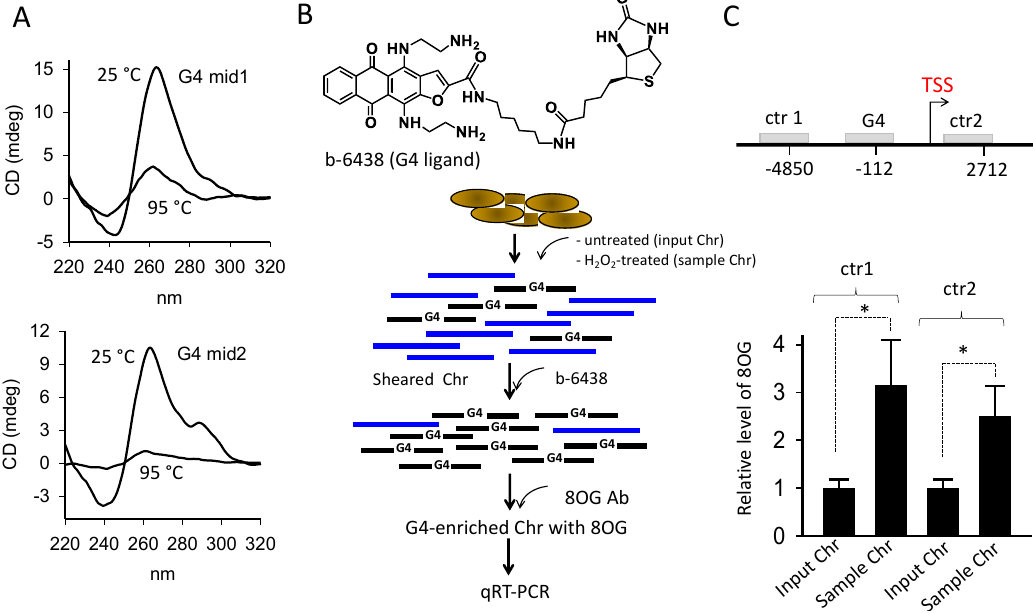
Figure 2. ( A ) CD spectra at 25 and 95 °C for the G4 mid1 and G4 mid2 sequences; ( B ) structure of biotinylated G4 ligand b-6438, which shows much more affinity for G4 DNA than duplex DNA, used in chromatin pull-down experiments. Pull down-ChIP experimental scheme. Chromatin fragments with G4 are depicted in black, fragments without G4 in blue; ( C ) the results of the pull down-ChIP experiment show that 8OG and the G4 motif co-localize in the region of the KRAS promoter containing G4 32R compared to control regions ctr1 and ctr2, located more than 4500 and 2500 bp away from TSS, respectively. Error bars from three experiments, Student t -test, (*) = p < 0.05.